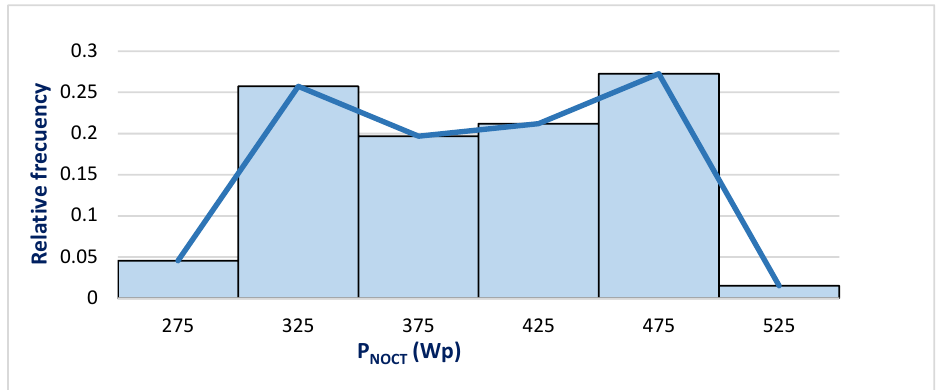
Figure 10. Histogram of the index P NOTC . Regarding the efficiency defined by the manufacturers for the PV modules used, η (%), it can be seen (Figure 11) that the efficiency range is between 18% and 24%, with the interval between 20% and 22% being the most frequent (90% of the cases studied).